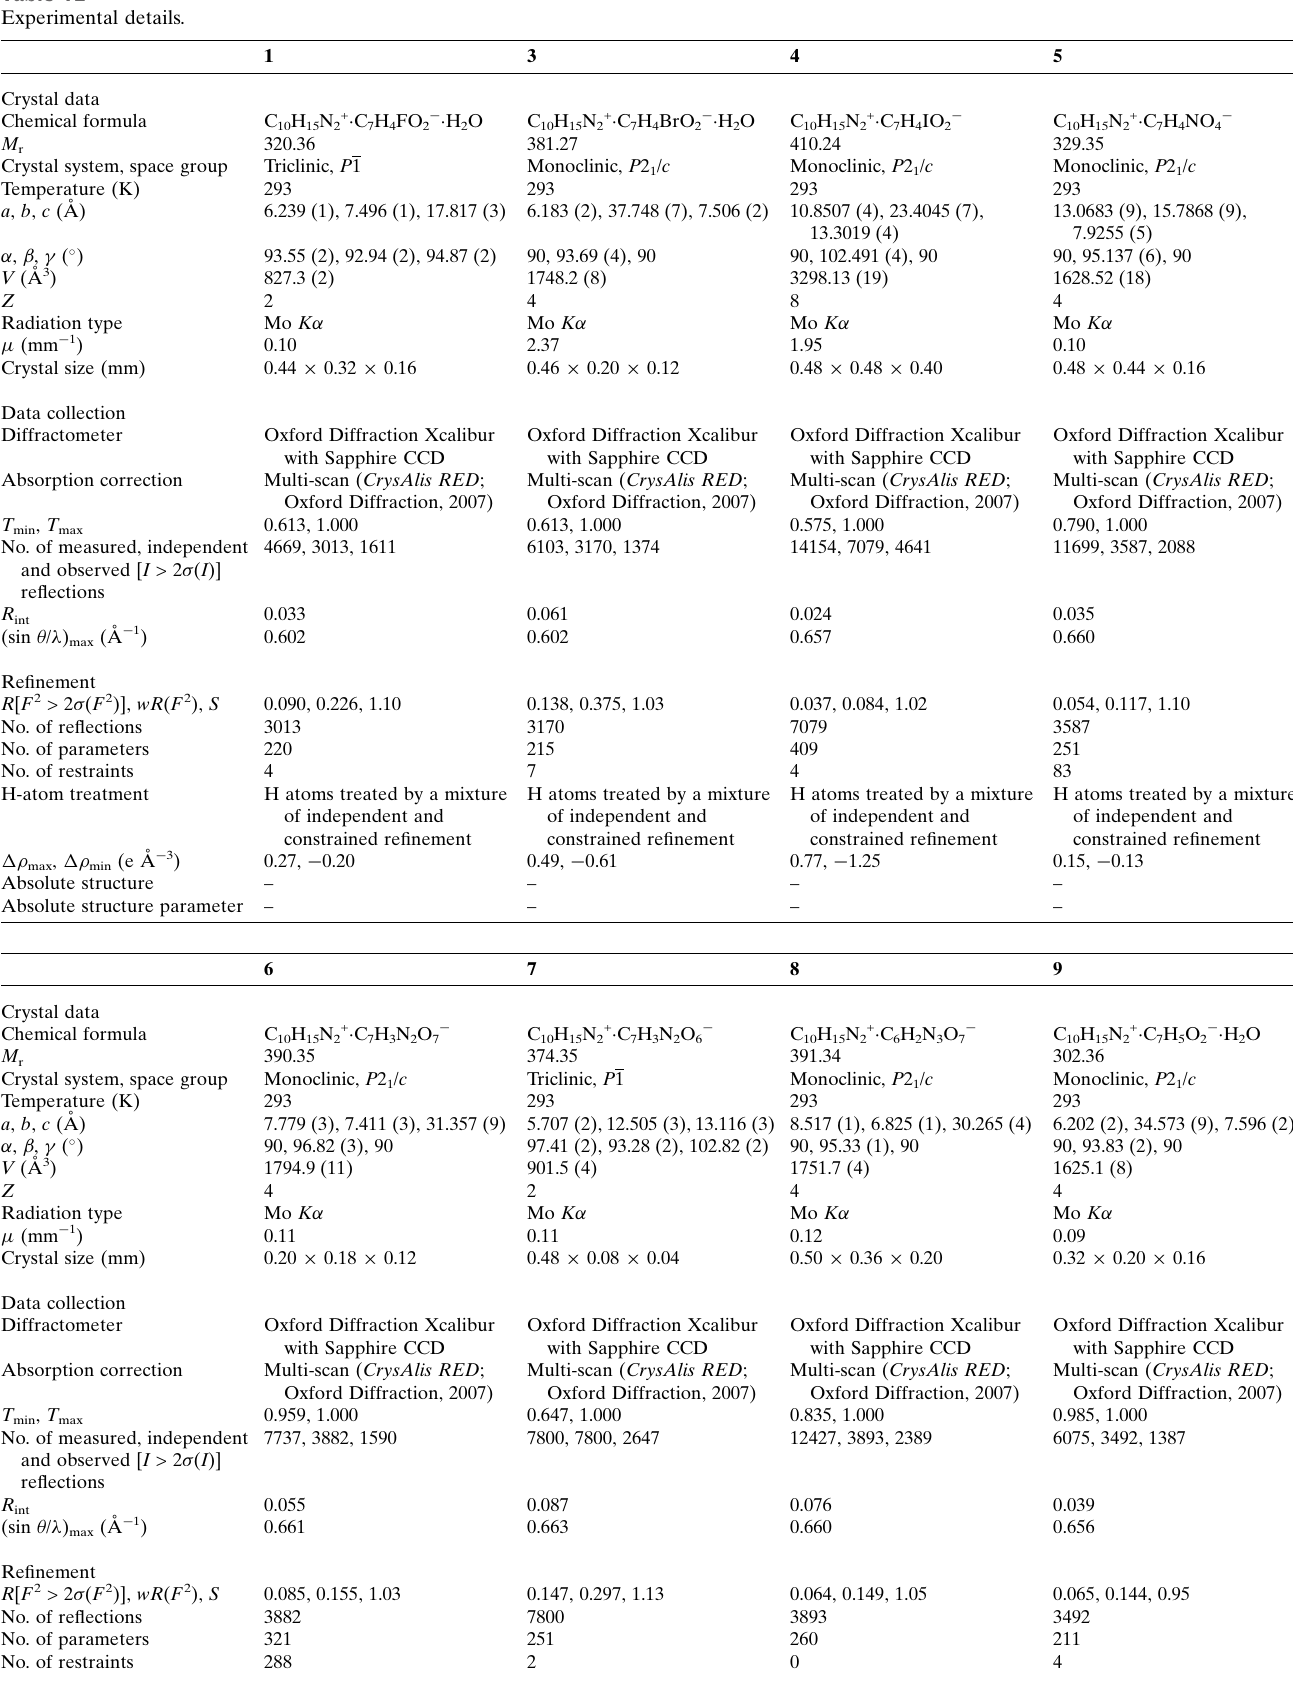
Table 12 Experimental details.